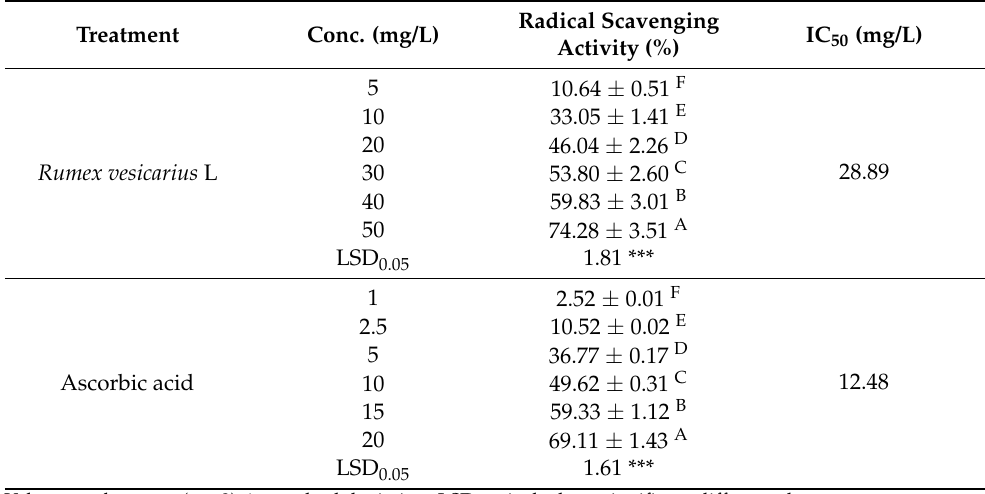
Table 2. Radical scavenging activity (%) and IC 50 values (mg/L) at various concentrations of the methanol extract of R. vesicarius and the standard ascorbic acid according to DPPH assay. Radical Scavenging IC 50 (mg/L) Treatment Conc. (mg/L) Activity (%)